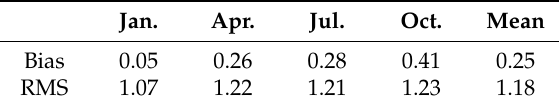
Table 3. Bias and RMS of real-time ZTD errors (unit: